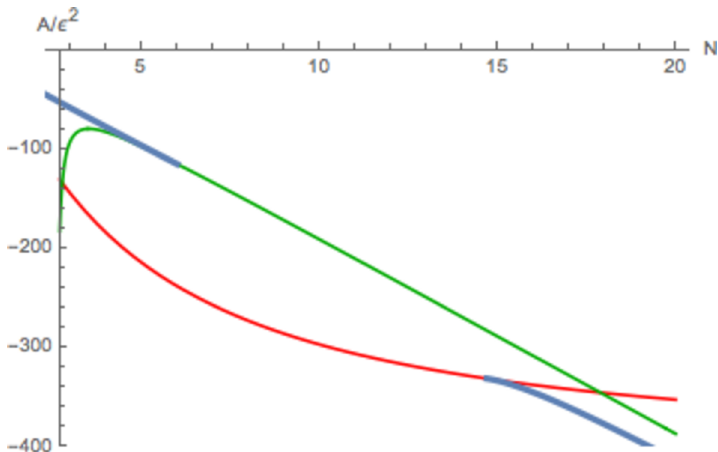
Figure 1 . A function for the O(N-1) fixed point (red), the SN invariant Potts model+free superfield (green), and the new SN invariant fixed point (blue). The new SN invariant fixed point goes to the complex plane after collision with the other fixed points. The RG flow is therefore not conformal in the IR, leading to a non-conformal